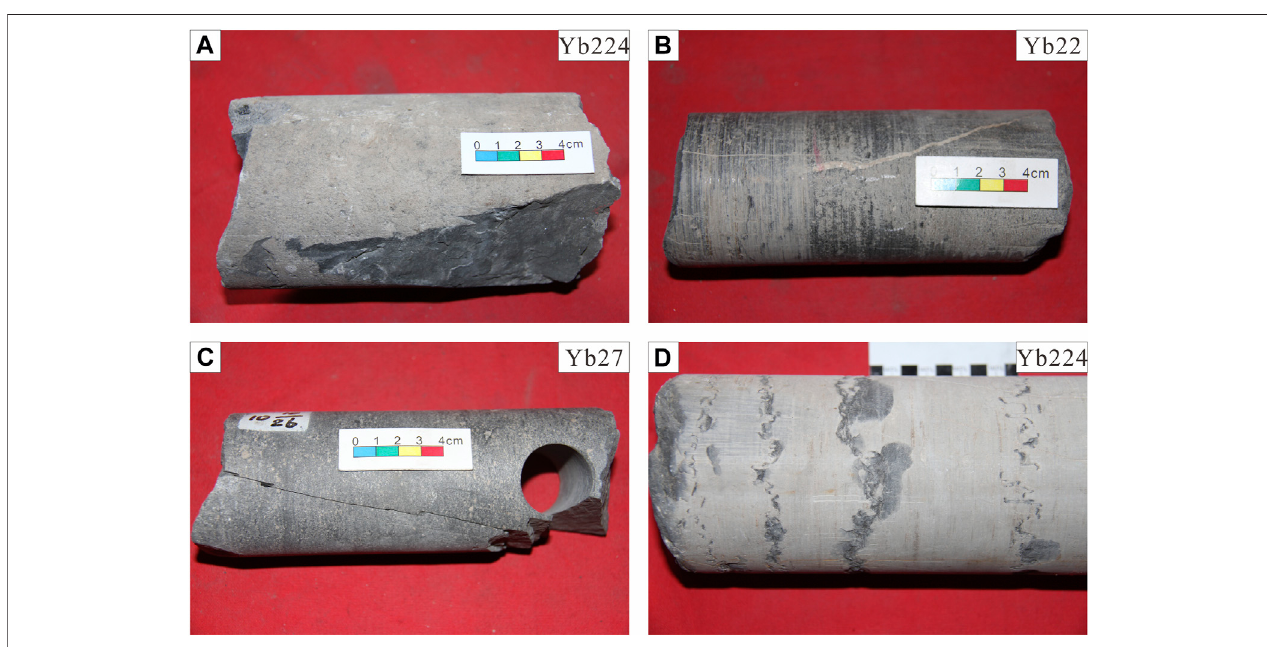
FIGURE 5 | Fractures in the Yuanba area. (A) Steep fractures fi lled by pitch in the Changxing Formation; (B) steep dip fractures fi lled by calcite in the Changxing Formation; (C) Steep dip fractures without fi lling in the Changxing Formation; (D) horizontal stylolites in the Feixianguan Formation.